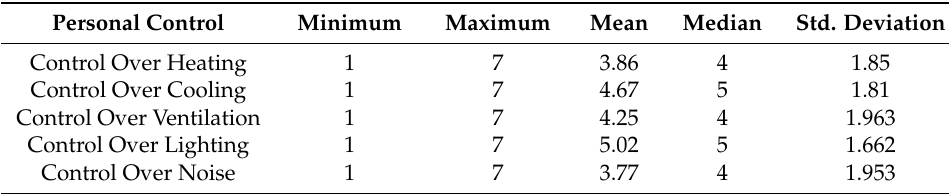
Table 5. Degree of control (1 = Little control; 7 = Full